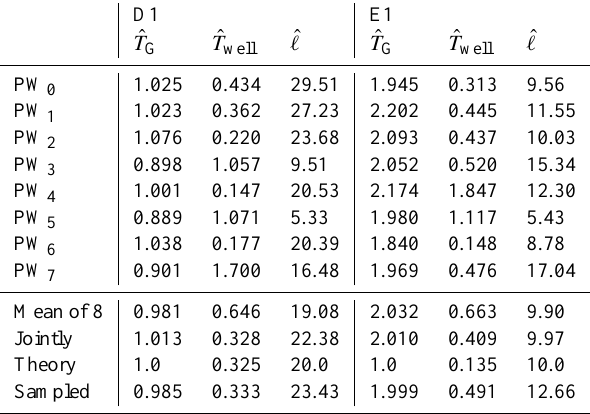
Table 2. Parameter estimates of geometric mean transmis- sivity